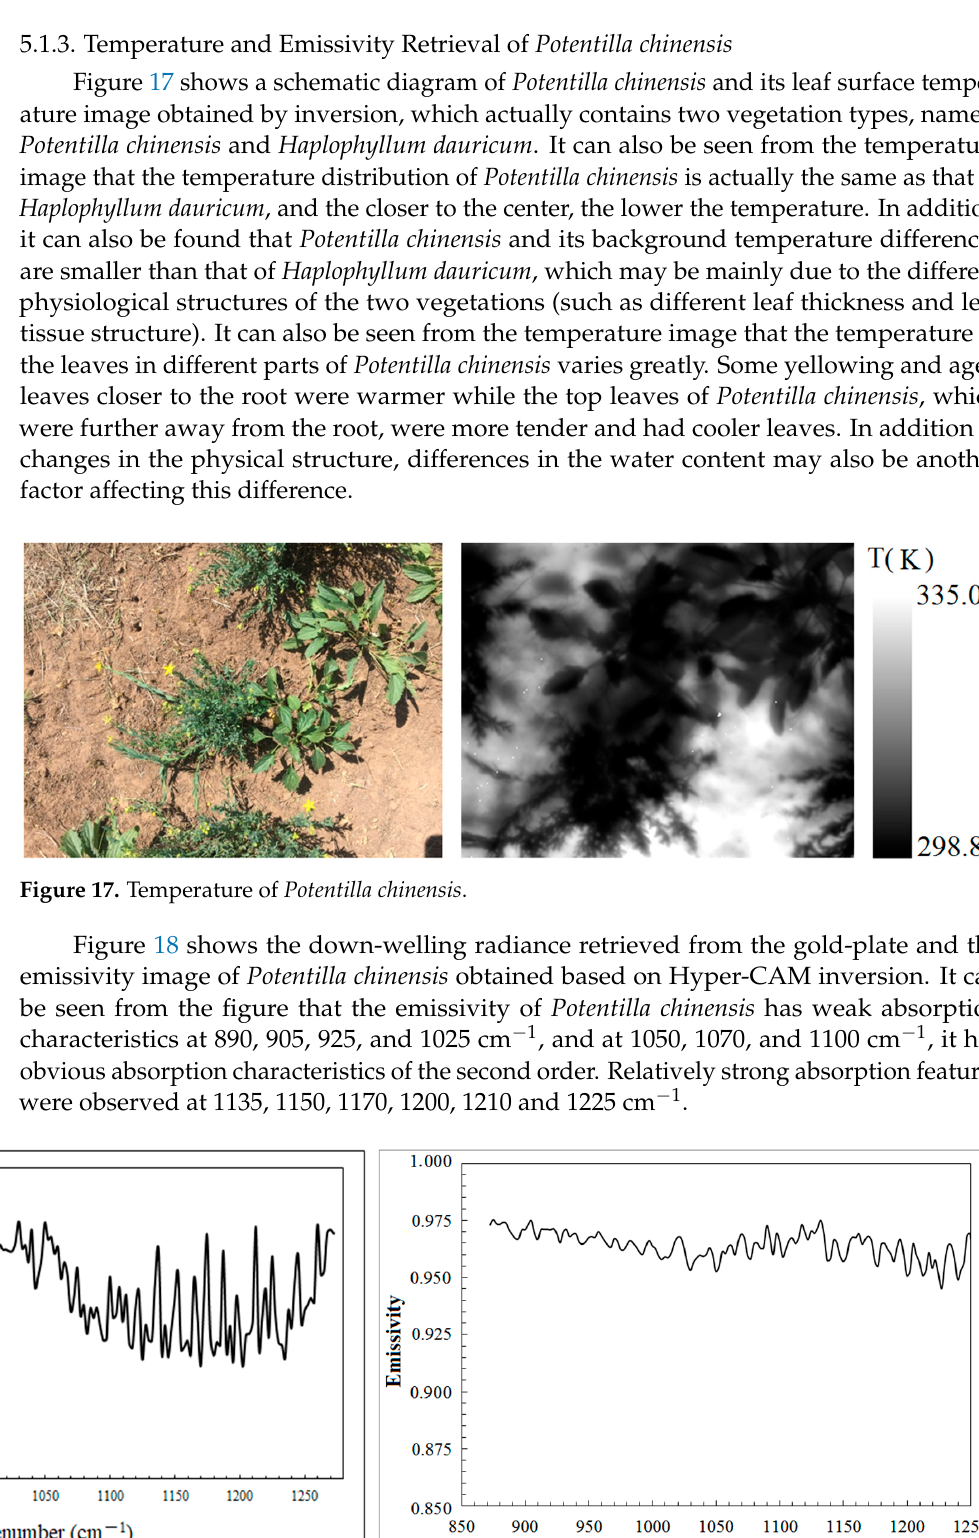
Figure 18. Results of emissivity retrieval and the down-welling radiance. ( a ) is the down-welling radiance retrieved from the gold-plate and ( b ) the emissivity of Potentilla chinensis .